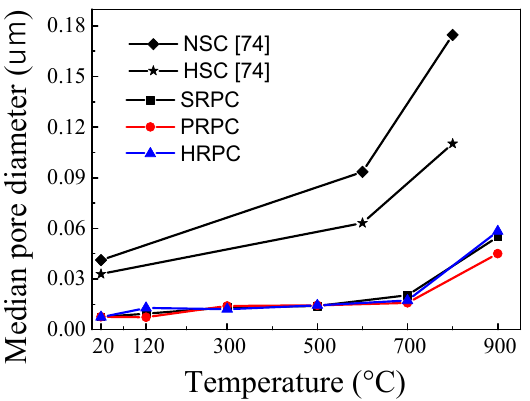
Figure 15. Median pore diameters of different RPCs at high temperature.